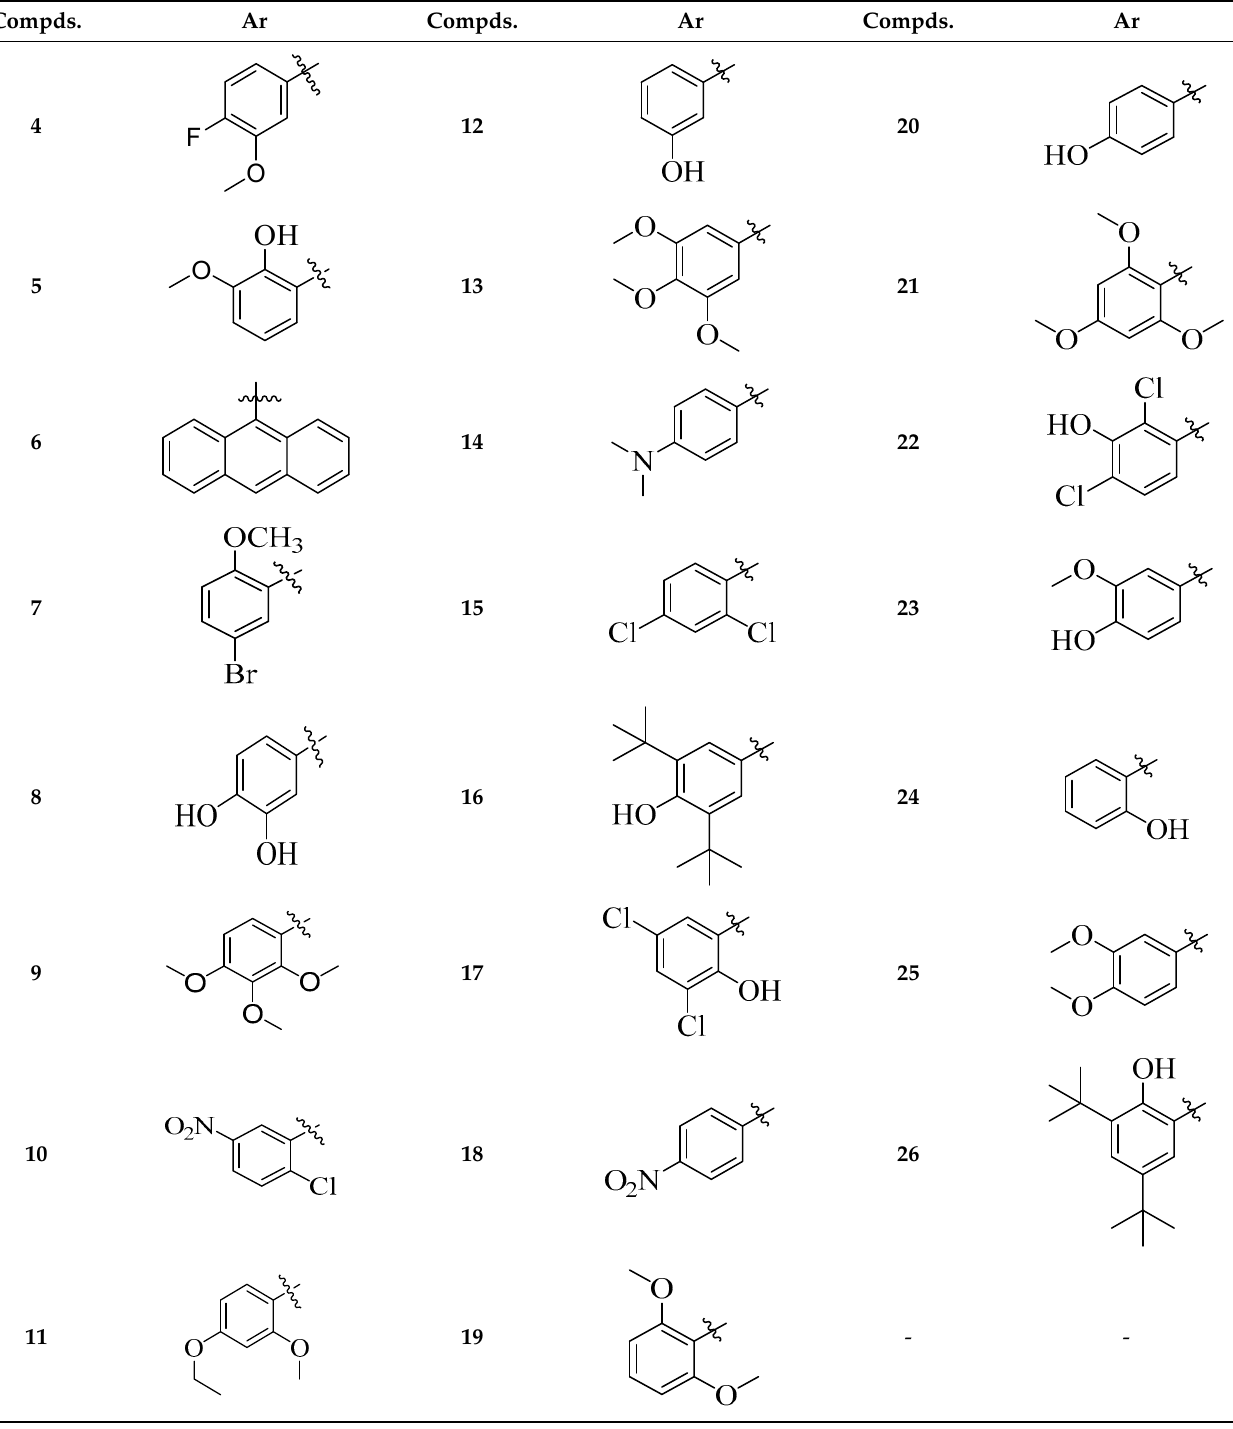
Table 1. Ar groups of synthesized N (cid:48) -benzylidene-4-(t-Bu)benzohydrazide derivatives ( 4 – 26 ). Table 1. Ar groups of synthesized N’ -benzylidene-4-(t-Bu)benzohydrazide derivatives ( 4–26 ). Table 1. Ar groups of synthesized N’ -benzylidene-4-(t-Bu)benzohydrazide derivatives ( 4–26 ). Table 1. Ar groups of synthesized N’ -benzylidene-4-(t-Bu)benzohydrazide derivatives ( 4–26 ). Table 1. Ar groups of synthesized N’ -benzylidene-4-(t-Bu)benzohydrazide derivatives ( 4–26 ). Table 1. Ar groups of synthesized N’ -benzylidene-4-(t-Bu)benzohydrazide derivatives ( 4–26 ). Table 1. Ar groups of synthesized N’ -benzylidene-4-(t-Bu)benzohydrazide derivatives ( 4–26 ). Table 1. Ar groups of synthesized N’ -benzylidene-4-(t-Bu)benzohydrazide derivatives ( 4–26 ). Table 1. Ar groups of synthesized N’ -benzylidene-4-(t-Bu)benzohydrazide derivatives ( 4–26 ). Table 1. Ar groups of synthesized N’ -benzylidene-4-(t-Bu)benzohydrazide derivatives ( 4–26 ). Table 1. Ar groups of synthesized N’ -benzylidene-4-(t-Bu)benzohydrazide derivatives ( 4–26 ). Table 1. Ar groups of synthesized N’ -benzylidene-4-(t-Bu)benzohydrazide derivatives ( 4–26 ). Table 1. Ar groups of synthesized N’ -benzylidene-4-(t-Bu)benzohydrazide derivatives ( 4–26 ). Compds. Table 1. Ar groups of synthesized N’ -benzylidene-4-(t-Bu)benzohydrazide derivatives ( 4–26 ). Compds. Table 1. Ar groups of synthesized N’ -benzylidene-4-(t-Bu)benzohydrazide derivatives ( 4–26 ). Compds. Table 1. Ar groups of synthesized N’ -benzylidene-4-(t-Bu)benzohydrazide derivatives ( 4–26 ). Compds. Table 1. Ar groups of synthesized N’ -benzylidene-4-(t-Bu)benzohydrazide derivatives ( 4–26 ). Compds. Compds. Compds. Table 1. Ar groups of synthesized N’ -benzylidene-4-(t-Bu)benzohydrazide derivatives ( 4–26 ). Table 1. Ar groups of synthesized N’ -benzylidene-4-(t-Bu)benzohydrazide derivatives ( 4–26 ). Table 1. Ar groups of synthesized N’ -benzylidene-4-(t-Bu)benzohydrazide derivatives ( 4–26 ). Table 1. Ar groups of synthesized N’ -benzylidene-4-(t-Bu)benzohydrazide derivatives ( 4–26 ). Compds. Compds. Compds. Table 1. Ar groups of synthesized N’ -benzylidene-4-(t-Bu)benzohydrazide derivatives ( 4–26 ). Compds. Table 1. Ar groups of synthesized N’ -benzylidene-4-(t-Bu)benzohydrazide derivatives ( 4–26 ). Compds. Compds. Table 1. Ar groups of synthesized N’ -benzylidene-4-(t-Bu)benzohydrazide derivatives ( 4–26 ). Compds. Compds. Compds. Ar Compds. Compds. Compds. Compds. Compds. Ar Compds. Compds. Compds. Compds. Compds.